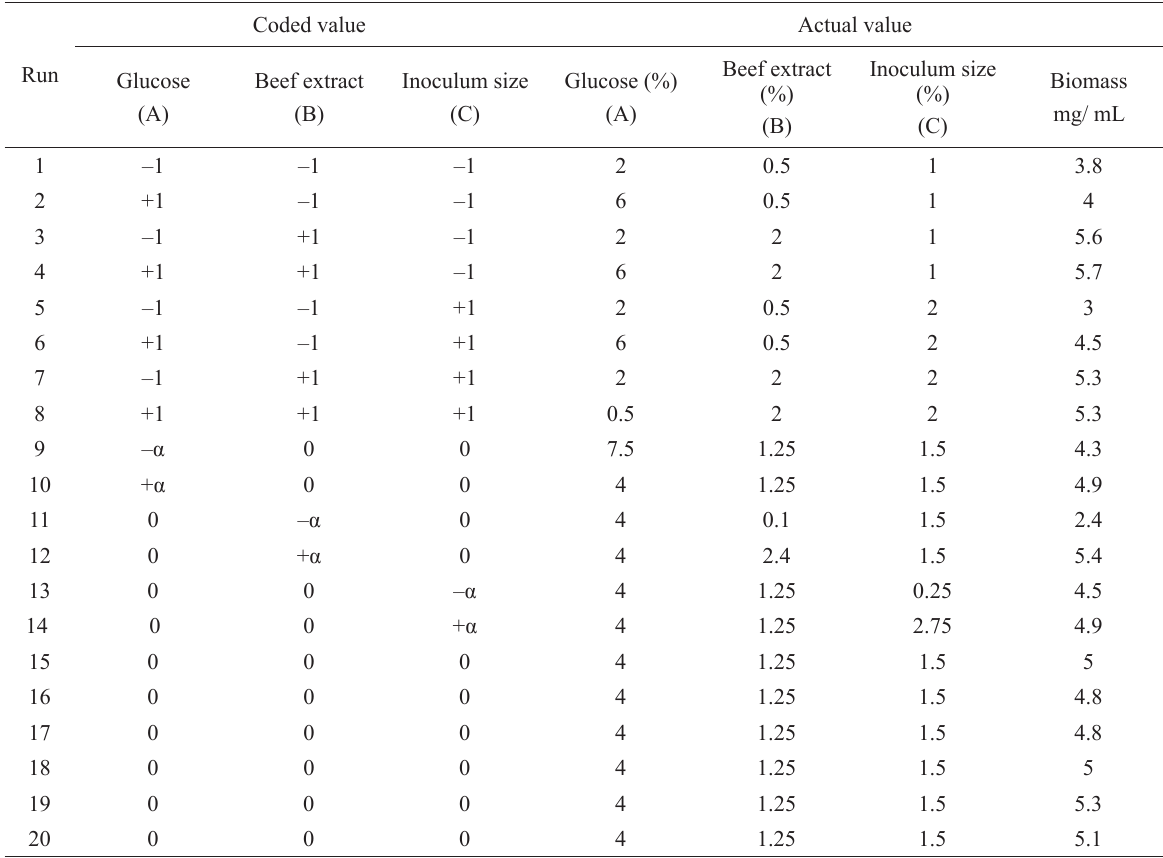
Central Composite Design showing production of Bacillus cereus strain IB311 at different variable combinations.